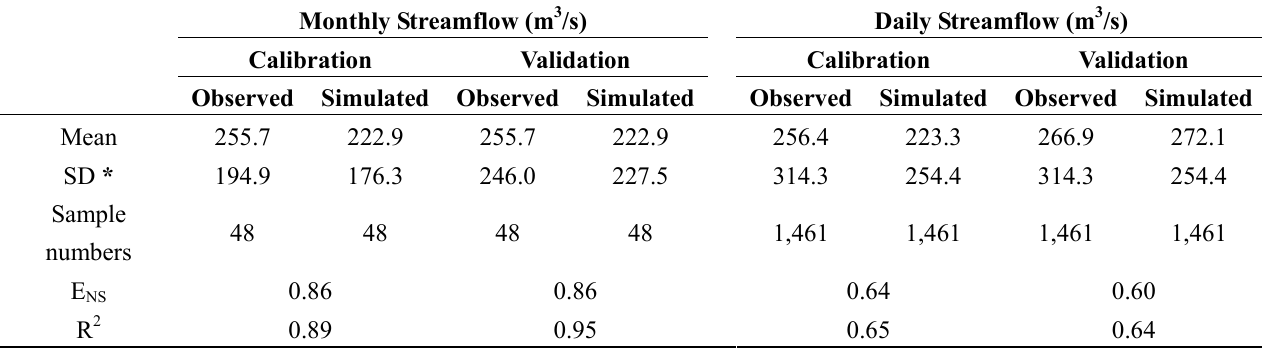
Table 3. Evaluation of monthly and daily streamflow simulation.